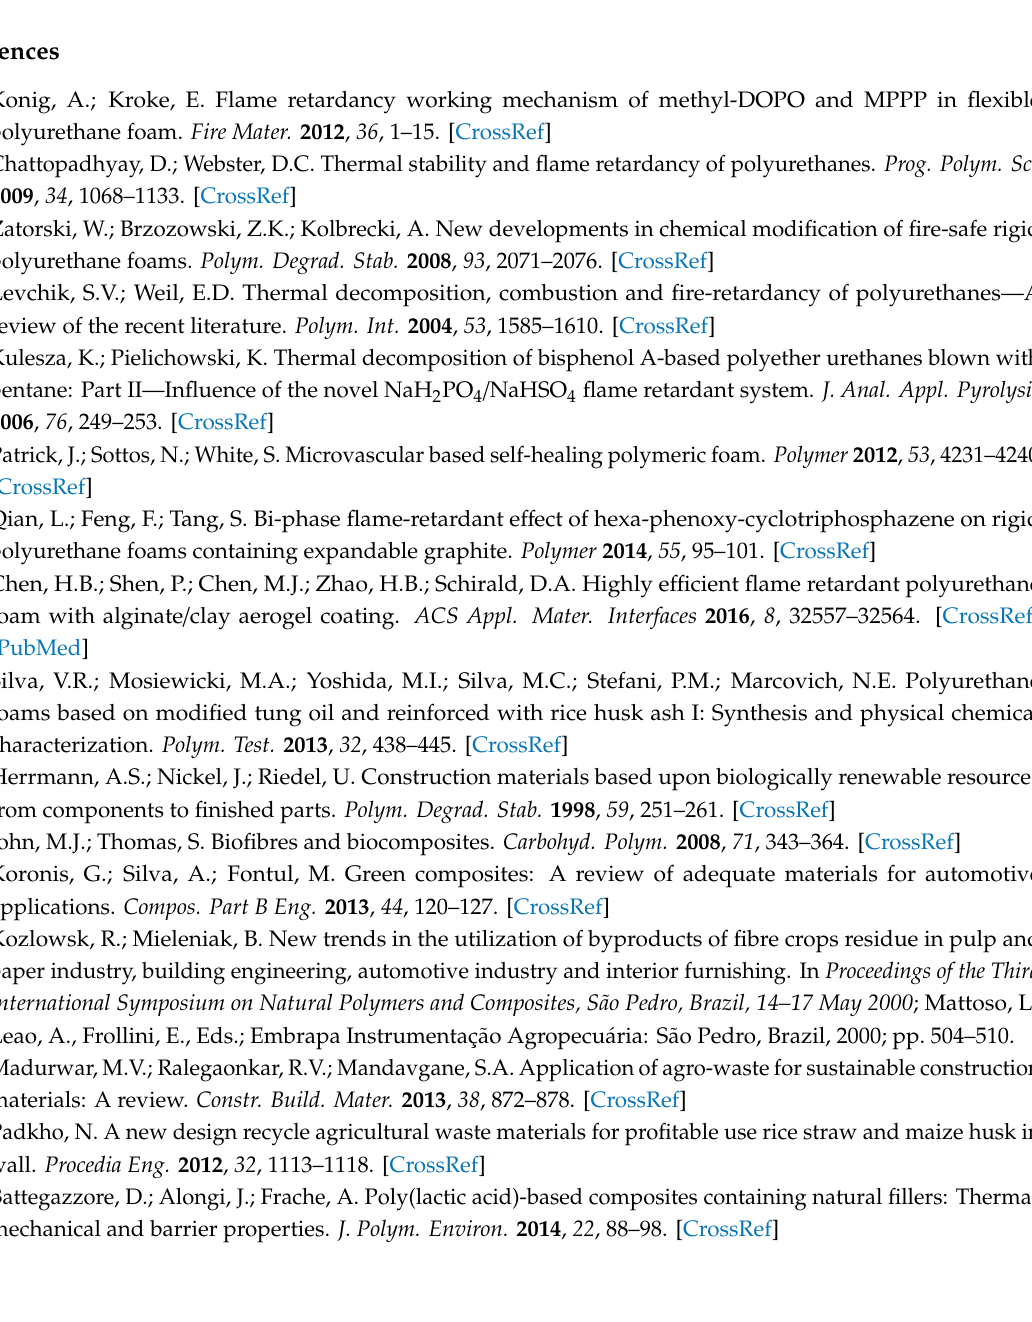
Figure S1: The digital photos of the residual char after cone calorimetry test of (a) PU–RH, (b) PU–RH / ATH, and (c) PU–RH / OP; Figure S2: FTIR spectra of PU–RH and PU–RH / FR residues after cone calorimetry test; Figure S3: SEM micrographs of PU–RH and PU–RH / FR residues after cone calorimetry